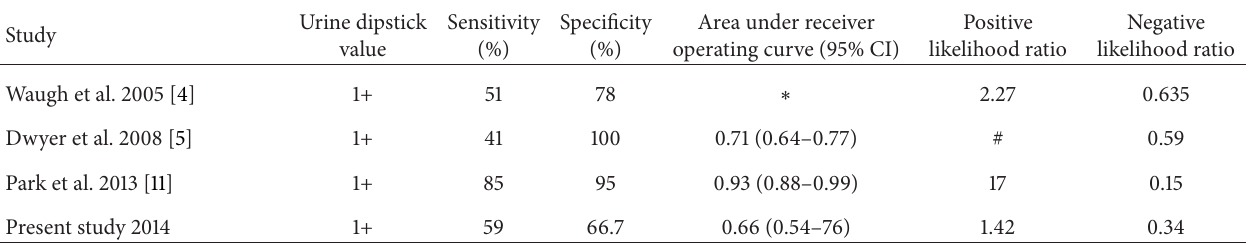
Table 6: Diagnostic utility of urine dipstick method for detection of significant